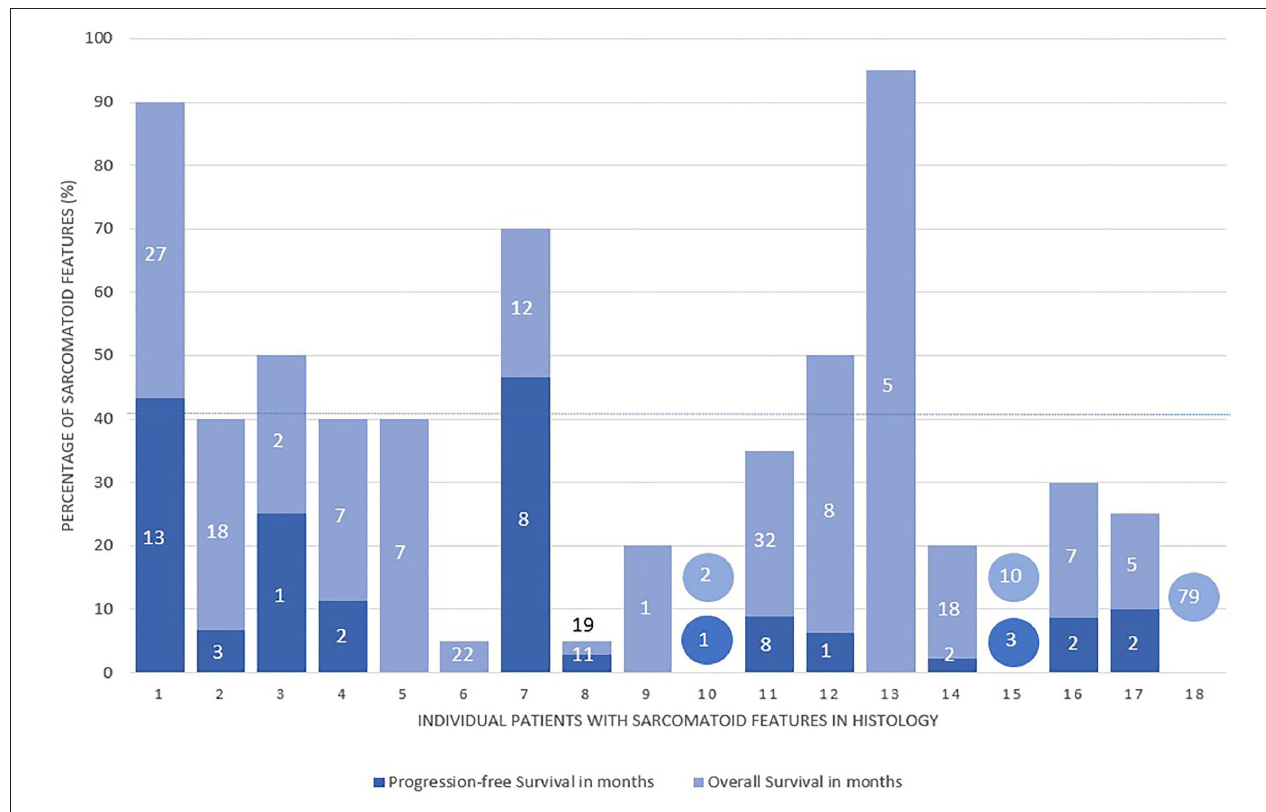
FIGURE 1 | Percentage of sarcomatoid tissue in the histological specimen of 18 patients with sRCC and their according overall survival (OS) and progression-free survival (PFS) in months. Missing values in OS and PFS are censored patients at the end of Follow-up. Values in circles are representing patients with percentage of sarcomatoid features unavailable. Mean percentage of sarcomatoid features in histology (41%; dotted line).